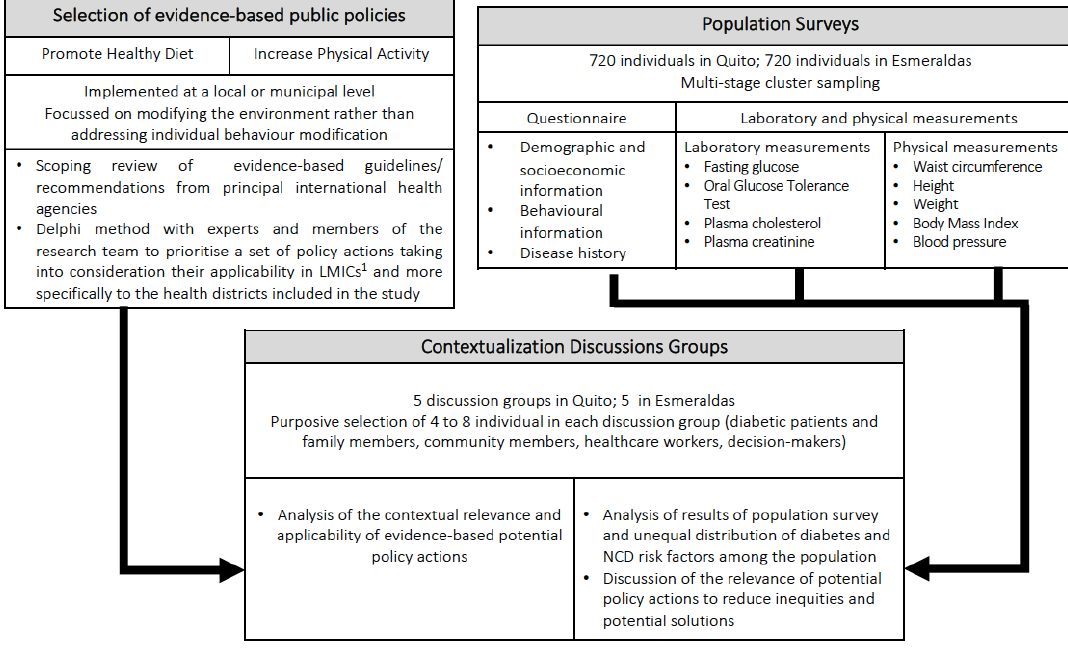
Figure 1. Study design used to analyse the contextual relevance and applicability to low-resource settings of a sample of evidence-based healthy public policies, using local knowledge, perceptions and pertinent epidemiological data. 1 LMICs: Low- and middle-income countries.